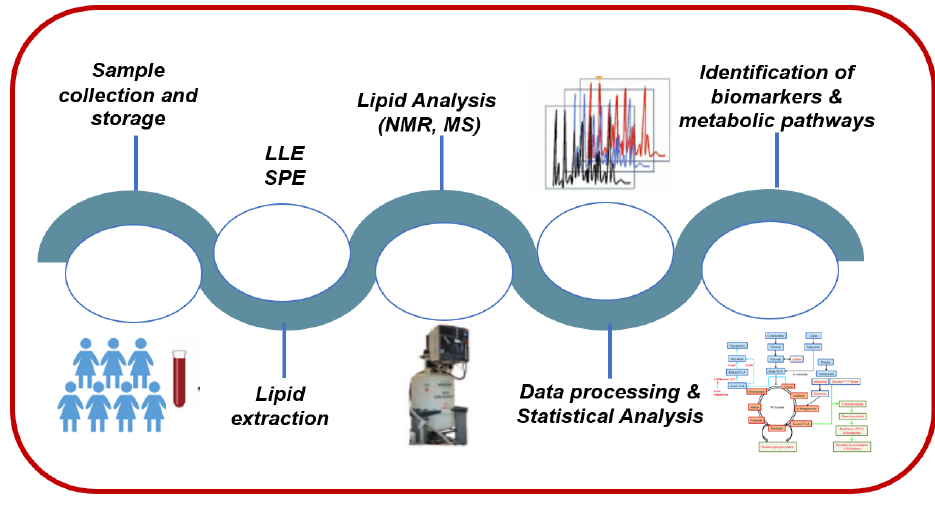
Figure 2. A representative lipidomics workflow.